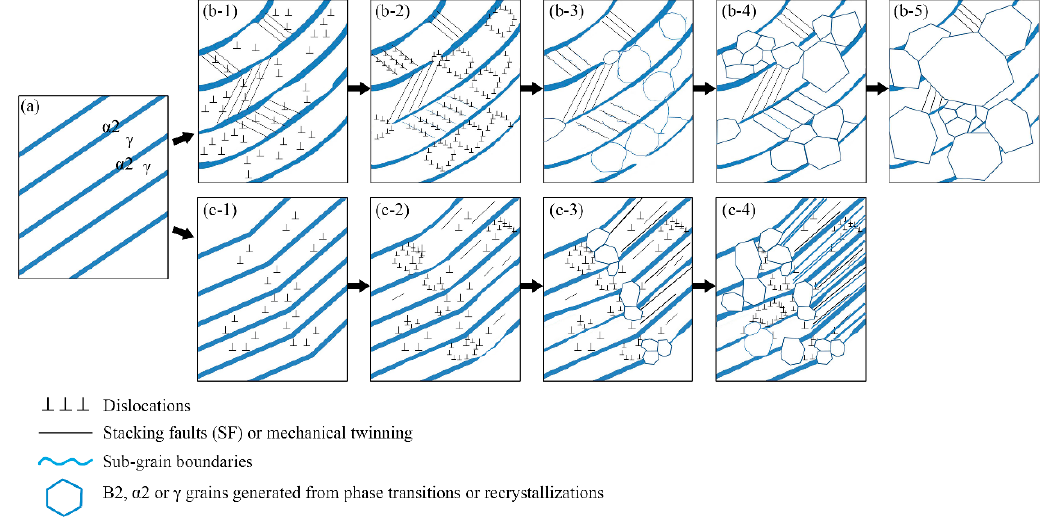
Figure 11. Schematic illustration showing the deformation processes of α 2/ γ lamellar colonies in Ti-44Al-5Nb-1Mo-2V-0.2B alloy.